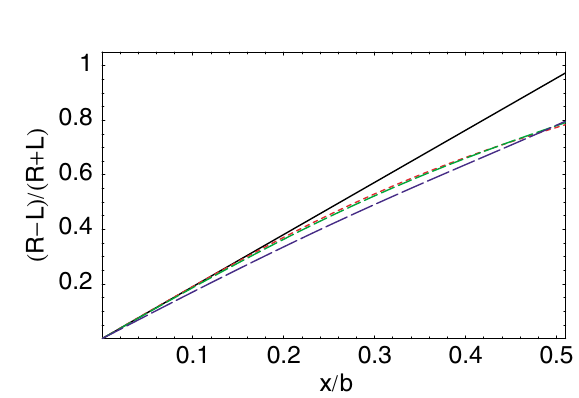
FIG. 3. (Color) Same as Fig. 2, but with beam-size corrections (cid:3) (cid:7) (cid:3) 0 ). x y (cid:3) 0 =b (cid:3) 0 : 2 , (cid:7) for a flat beam with (cid:7) x y